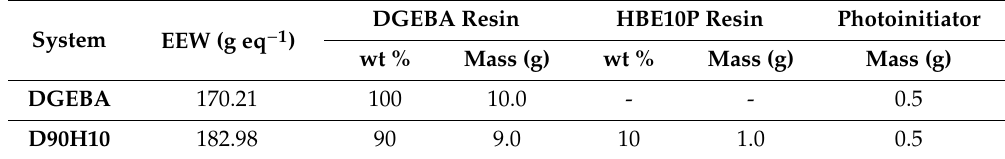
Table 1. The mixture of epoxy